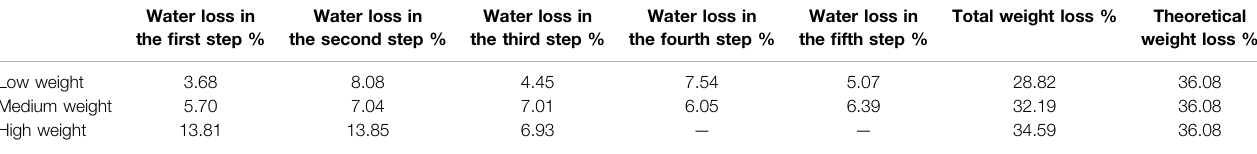
TABLE 2 | Weight-loss data of chalcanthite with different weights obtained according to the thermogravimetry curve corresponding to the differential thermal peak.